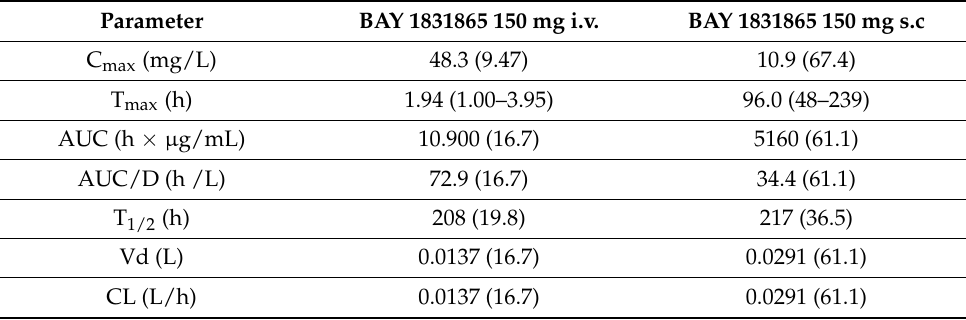
Table 5. Plasma pharmacokinetic parameters of BAY 1831865. Geometric Mean (Geometric Mean CV%) BAY 1831865 PK parameters. For T max , data are presented as median (min-max). Data are from Nowotny B. et al. [26]. C max : Maximum plasma concentration; T max : time to reach C max . AUC: area